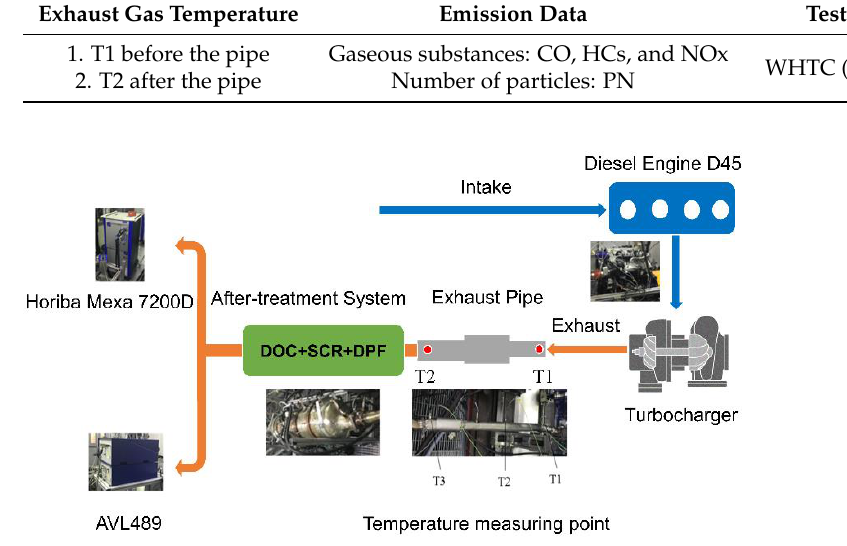
Figure 2. Layout of the test bench and temperature measurement points.